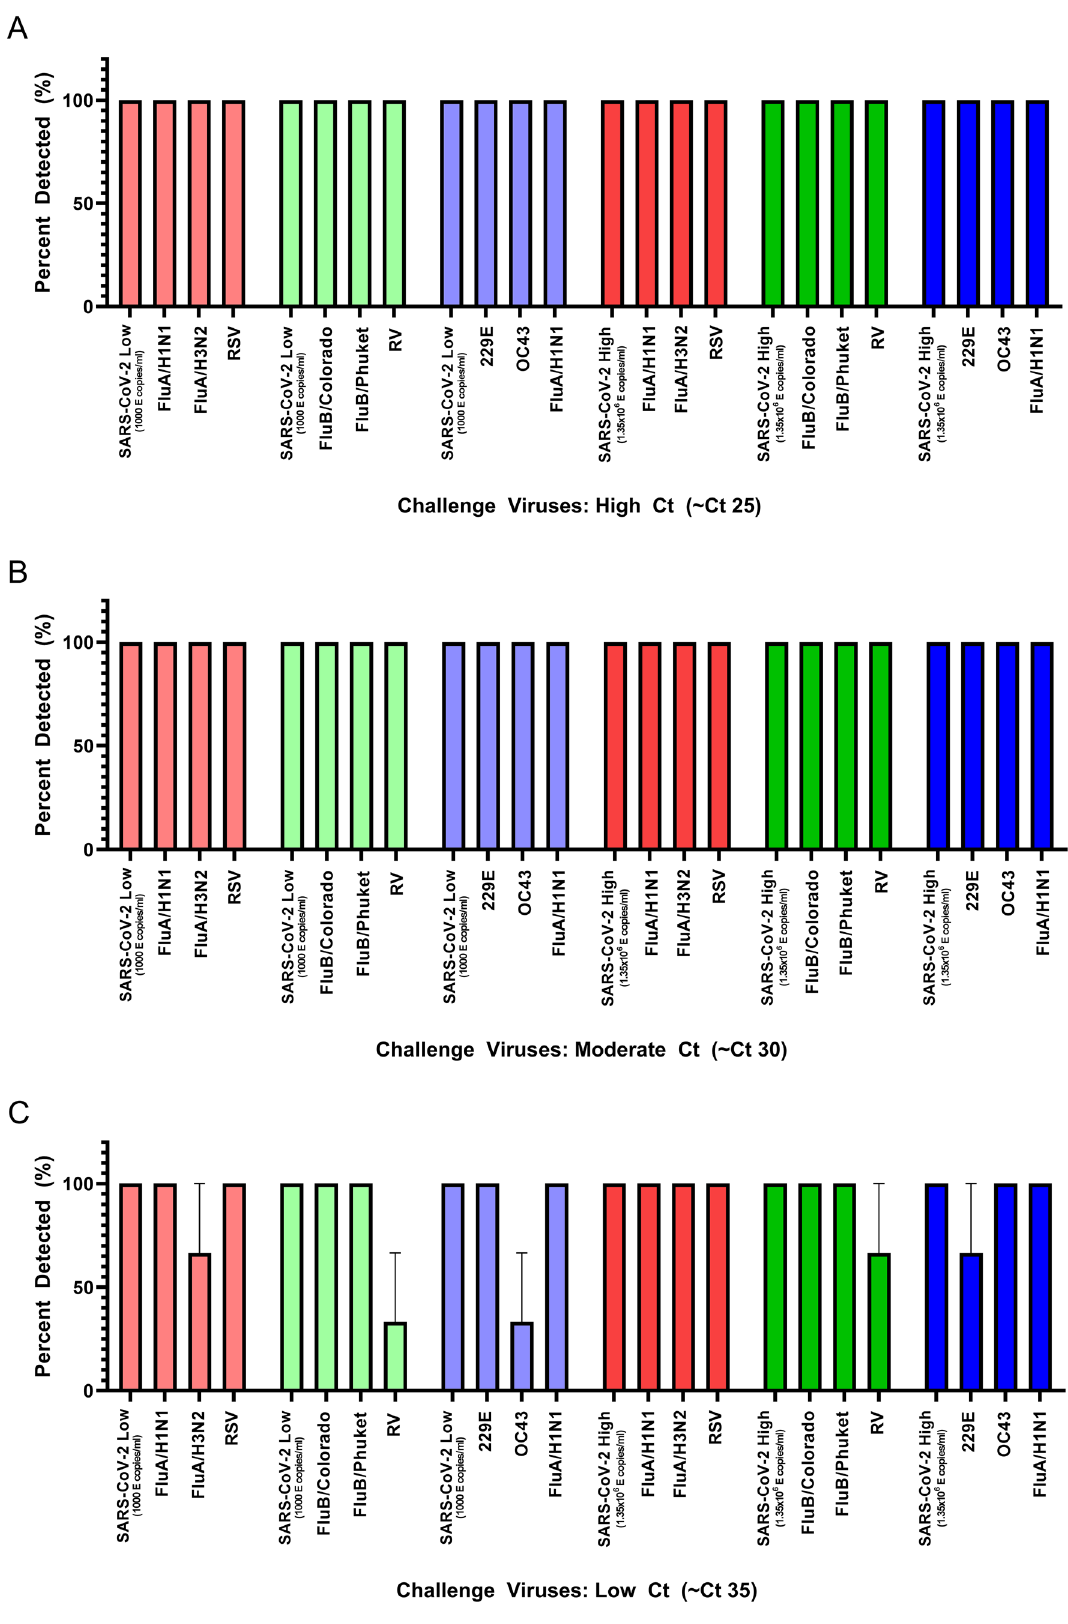
Figure 3. Detection of SARS-CoV-2 and challenge respiratory viruses after a four specimen-pooling strategy using the FilmArray RP2.1. A contrived-clinical sample containing 1000 E copies/ml or 1.35 × 10 6 E copies/ml of SARS-CoV-2 was equally mixed with three contrived samples containing ( A ) high (~ Ct 25), ( B ) moderate (~ Ct 30), or ( C ) low (~ Ct 35) amounts of either Flu A, FluB, RSV, RV, OC43, and 229E. The FilmArray RP2.1 was employed to detect the presence of SARS-CoV-2. Each coloured set denotes a separate pool. Each pool was tested in triplicate and the mean and standard error are